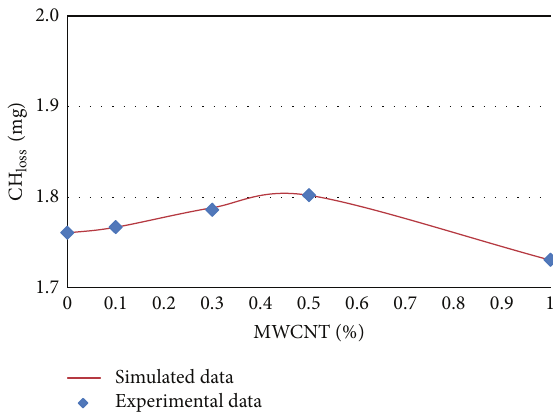
for 28 days Figure 9: Experimental and simulated values of CH loss for 7 days by loss artificial neural networks.